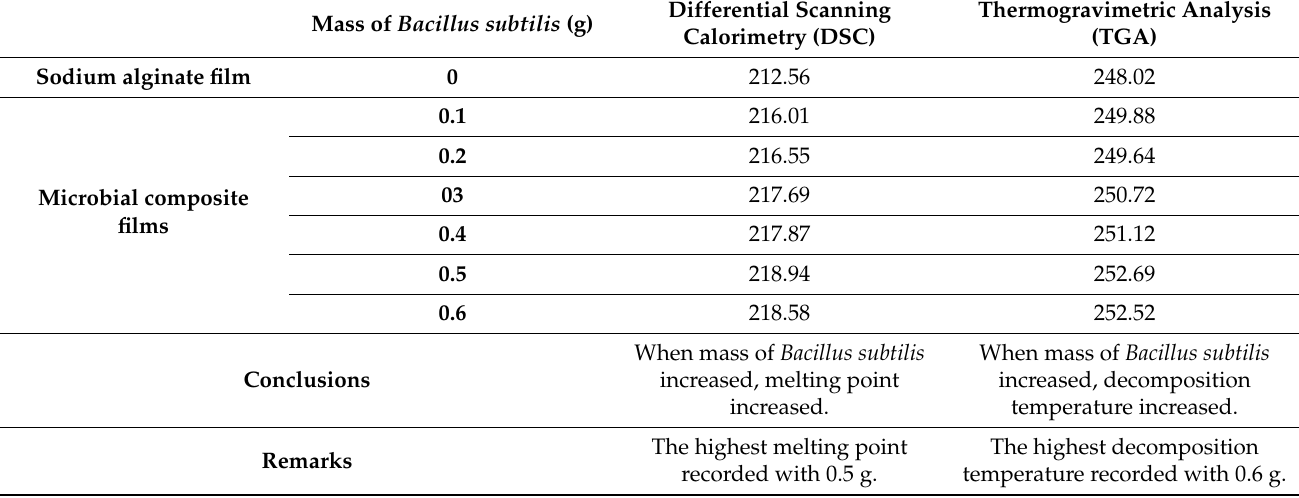
Table 5. Differential scanning calorimetry (DSC) and thermogravimetric analysis (TGA) of sodium alginate and microbial composite